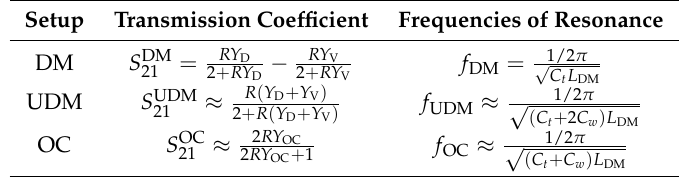
Figure 3. Balanced and unbalanced setups for measuring transmission coefficients conveying information about the attenuation provided by a CMC for a differential mode excitation. Measurements can be performed with a spectrum analyzer (SA) with tracking generator (TG) or a VNA. Table 1. Transmission coefficients and frequencies of resonance for a CMC measured in the setups of Figure 3, where Y OC = Y H Y D / ( Y H + Y D ) . Approximated expressions assume C g (cid:28) C t , C w and Y C (cid:28) Y V , Y H , Y D